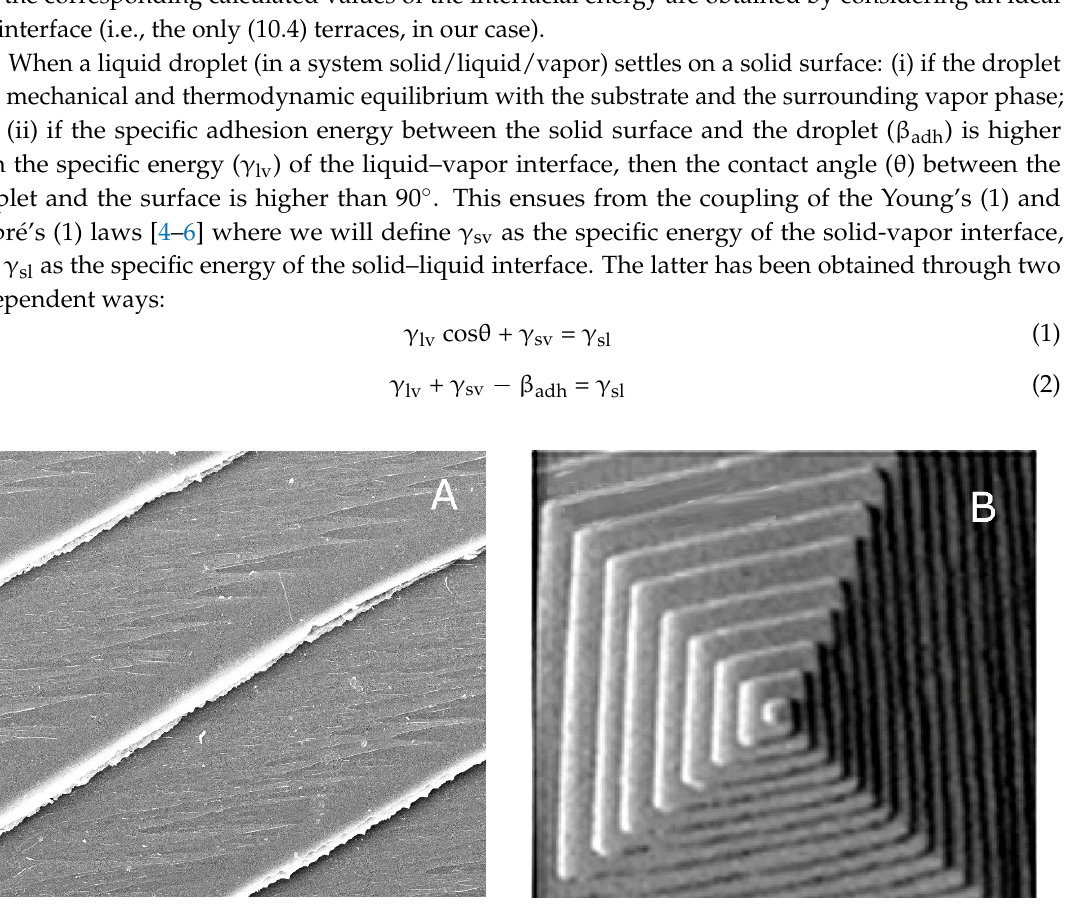
Figure 1. SEM images of calcite crystal surfaces showing features at different scales. ( A ) A sequence of thin and thick cleavage steps on a {10.4} face of a calcite crystal: the mean step spacing is close to 50 μ m, while the mean height of thick steps is close to 1 μ m. F.O.V. 100 μ m (by courtesy of Dr. Linda